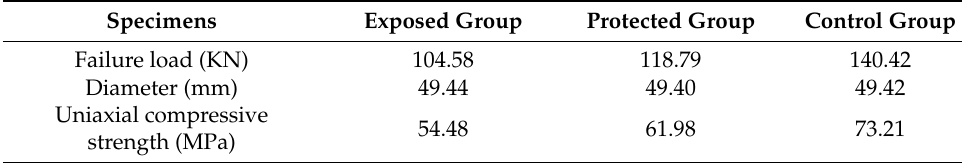
Table 3. Uniaxial compressive strength of specimens.